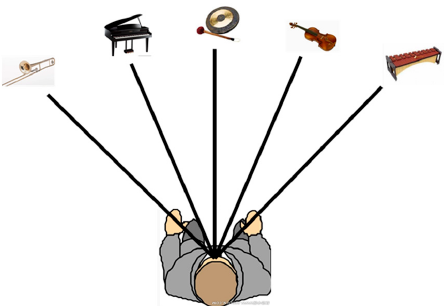
Figure 13. Non-semantic stereophonic interface of the assisting system. Sounds of five directions of traversable area are presented by five musical instruments in 3D space, including trumpet, piano, gong, violin, and xylophone.